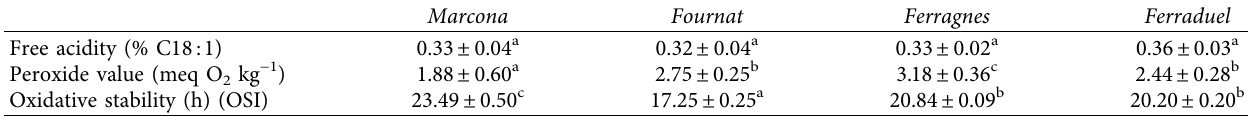
Table 1: Quality indexes of almond oils of the four studied varieties produced in eastern Morocco.